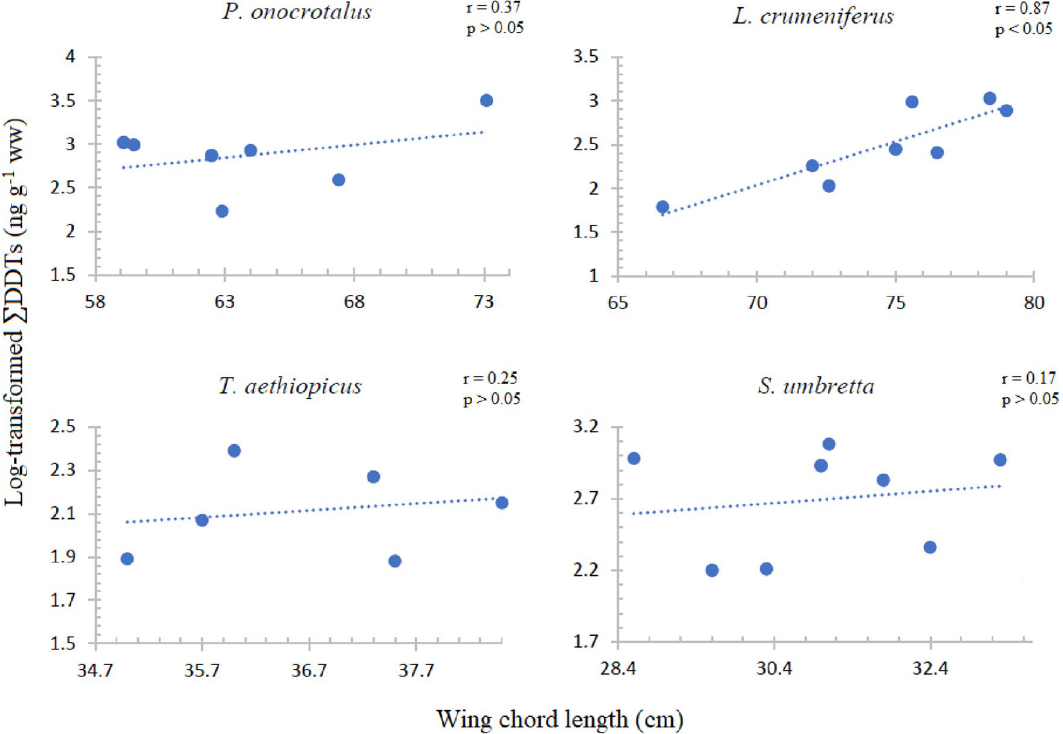
Fig. 3 Relationship between log-transformed ∑DDTs (ng g −1 ww) and wing chord length (cm)